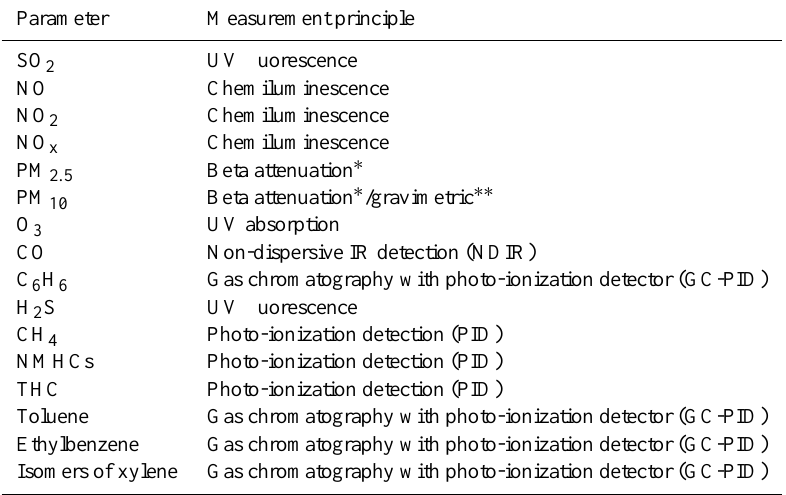
Table 1. Summary of the methods used for measuring concentrations of each pollutant.